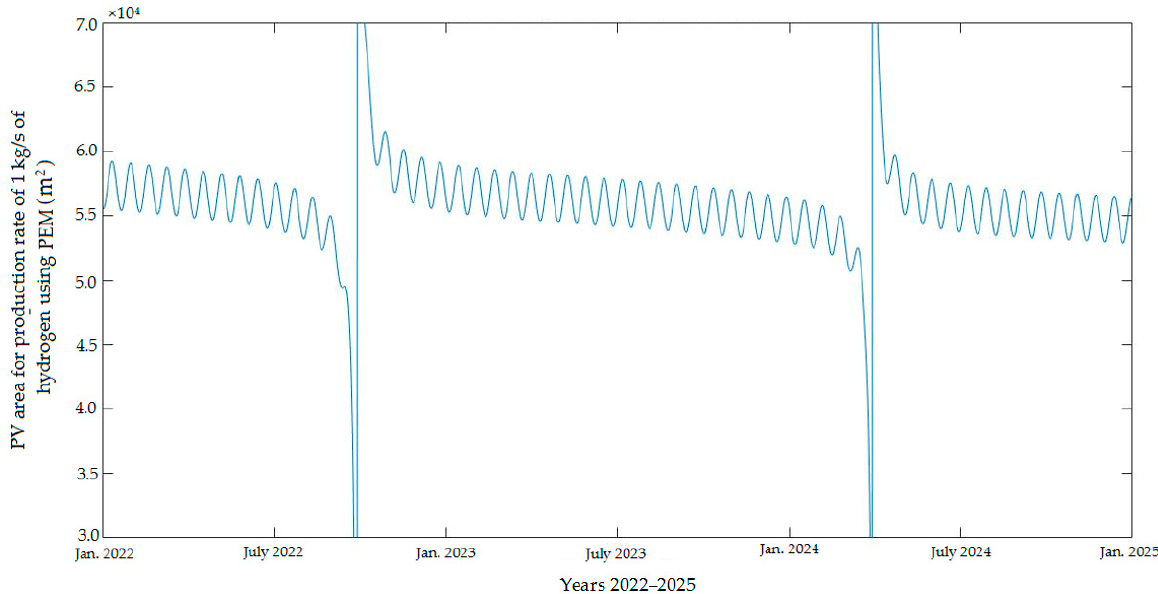
Figure 7. Forecasting the PV area required to produce 1 kg/s of hydrogen using a PEM electrolyzer during 2022–2025.